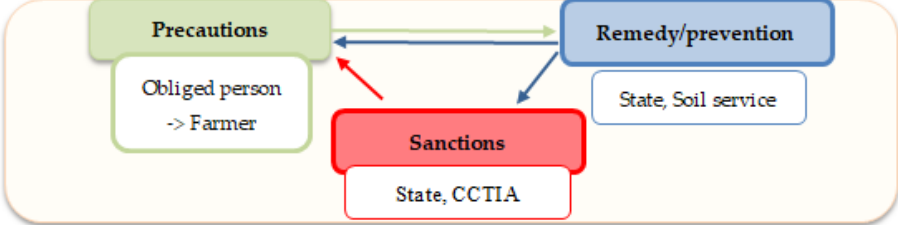
Figure 8. Environmental and legal liability for agricultural land protection pursuant to the Act No 220/2004 Coll. Source: own representation based on the Act No 220/2004 Coll. [61]. 220/2004 Coll. Source: own representation based on the Act No 220/2004 Coll.